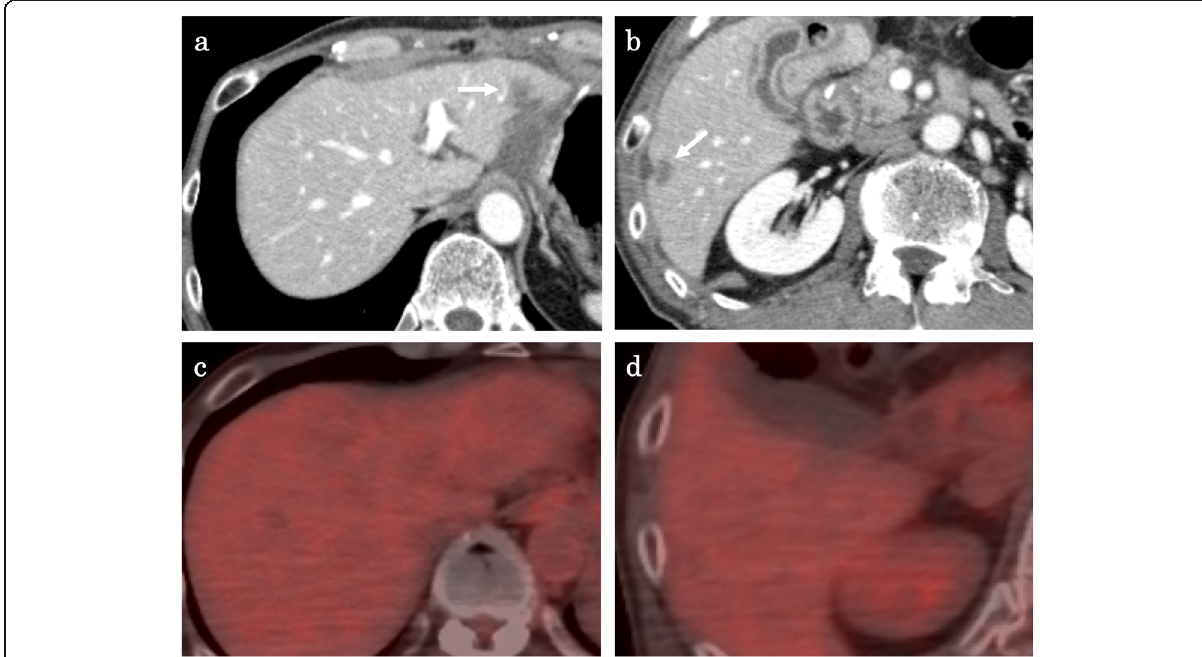
Fig. 6 Liver nodules after chemotherapy. The hepatic nodules in segment 2/3 and segment 6 had dramatically reduced in size to 14 mm in diameter ( a ) and 15 mm in diameter ( b ), respectively (white arrow). c , d Neither tumor showed 18F-FDG